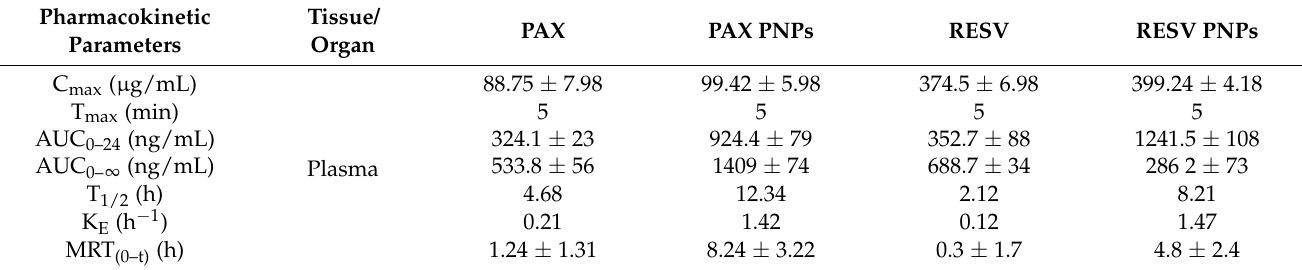
Table 4. Pharmacokinetic parameters following i.v. administration.